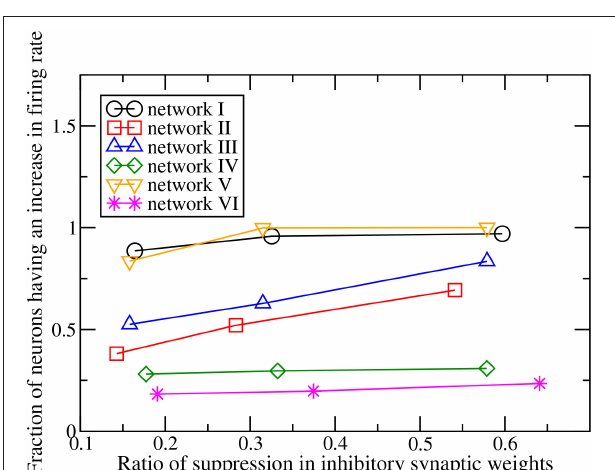
FIGURE 5 | Dependence of the fraction of neurons having an increase in firing rate on the ratio of suppression in inhibitory synaptic weights for the six